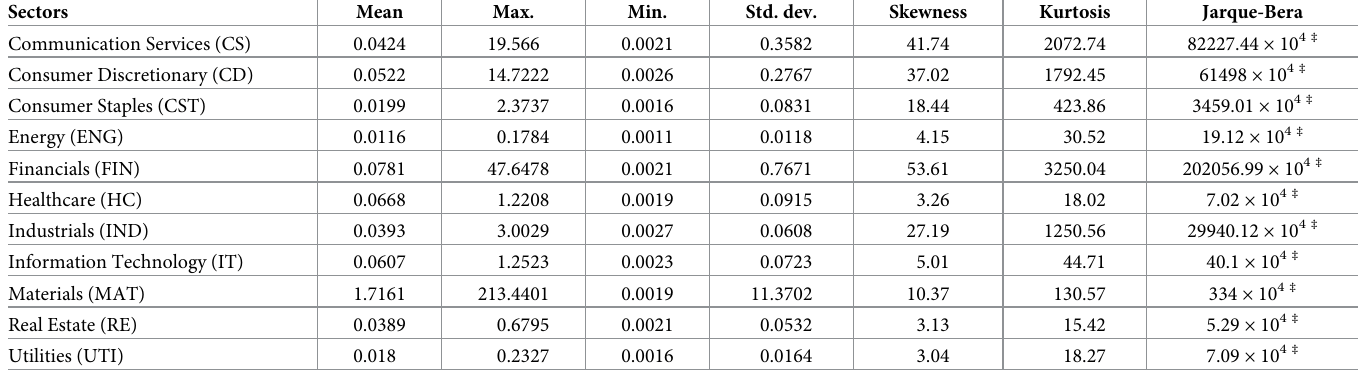
Table 1. Summary statistics for the average sector liquidity measure for the 11 sectors in the S&P 500 index. The Jarque-Bera statistic tests the null hypothesis of nor- mality for the sample returns. Sectors Mean Max. Min. Std. dev. Skewness Kurtosis